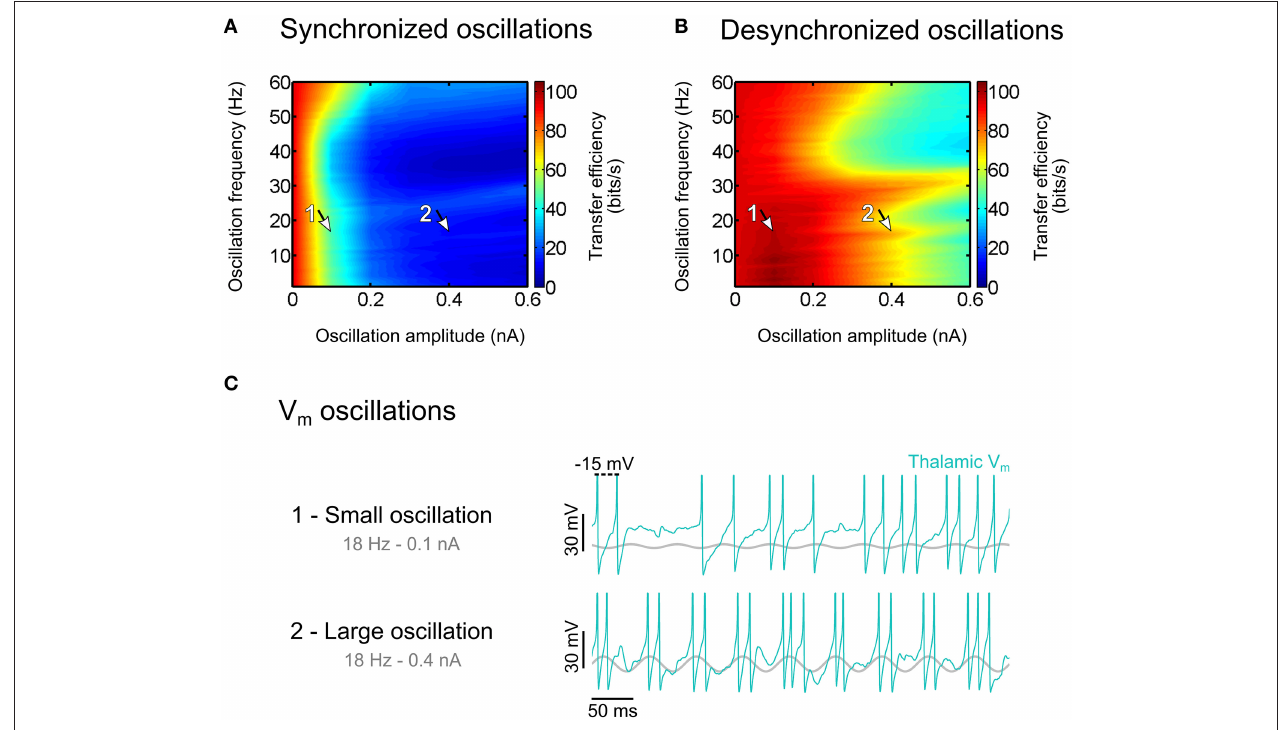
FIGURE 8 | Effect of thalamic oscillations on sensory information transfer. (A) Transfer efficiency for synchronized oscillations. (B) Same as (A) for desynchronized oscillations. (C) Thalamic membrane potential traces for oscillation amplitudes of 0.1nA [arrow 1 in (A) , degraded transfer] and 0.4nA [arrow 2 in (B) , permissive transfer]. Modified from Béhuret et al.